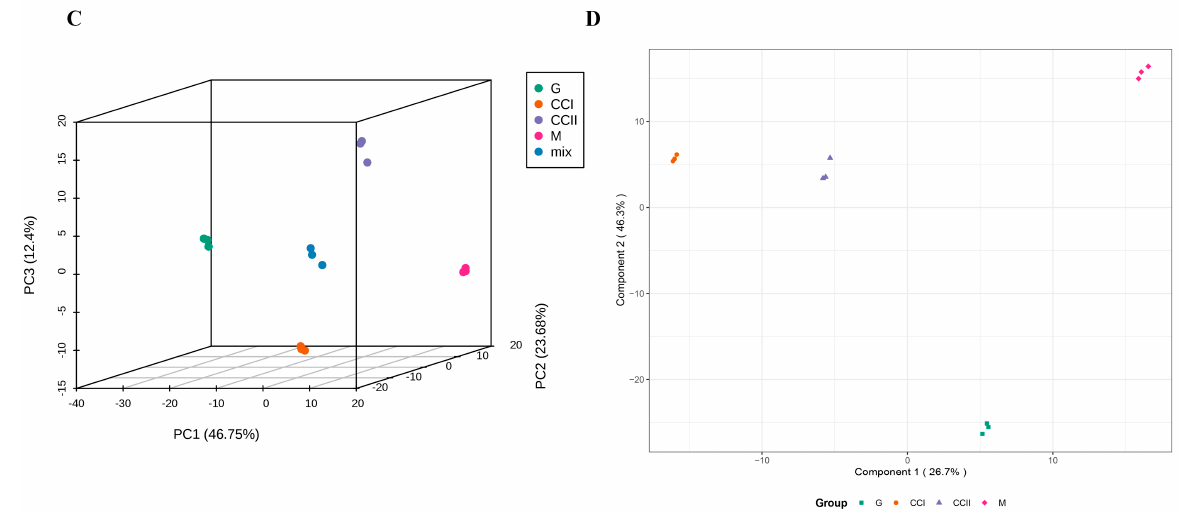
Figure 1. Differential fruit chemotype between ‘Shushanggan apricot’ fruits at four developmental stages. ( A ): Heat map of the identified metabolites; ( B ): Correlation analysis of four sets of samples; ( C ): Principal component analysis of metabolomics data (PCA 3D plot); ( D ): Orthogonal signal correction and partial least squares-discriminant analysis.